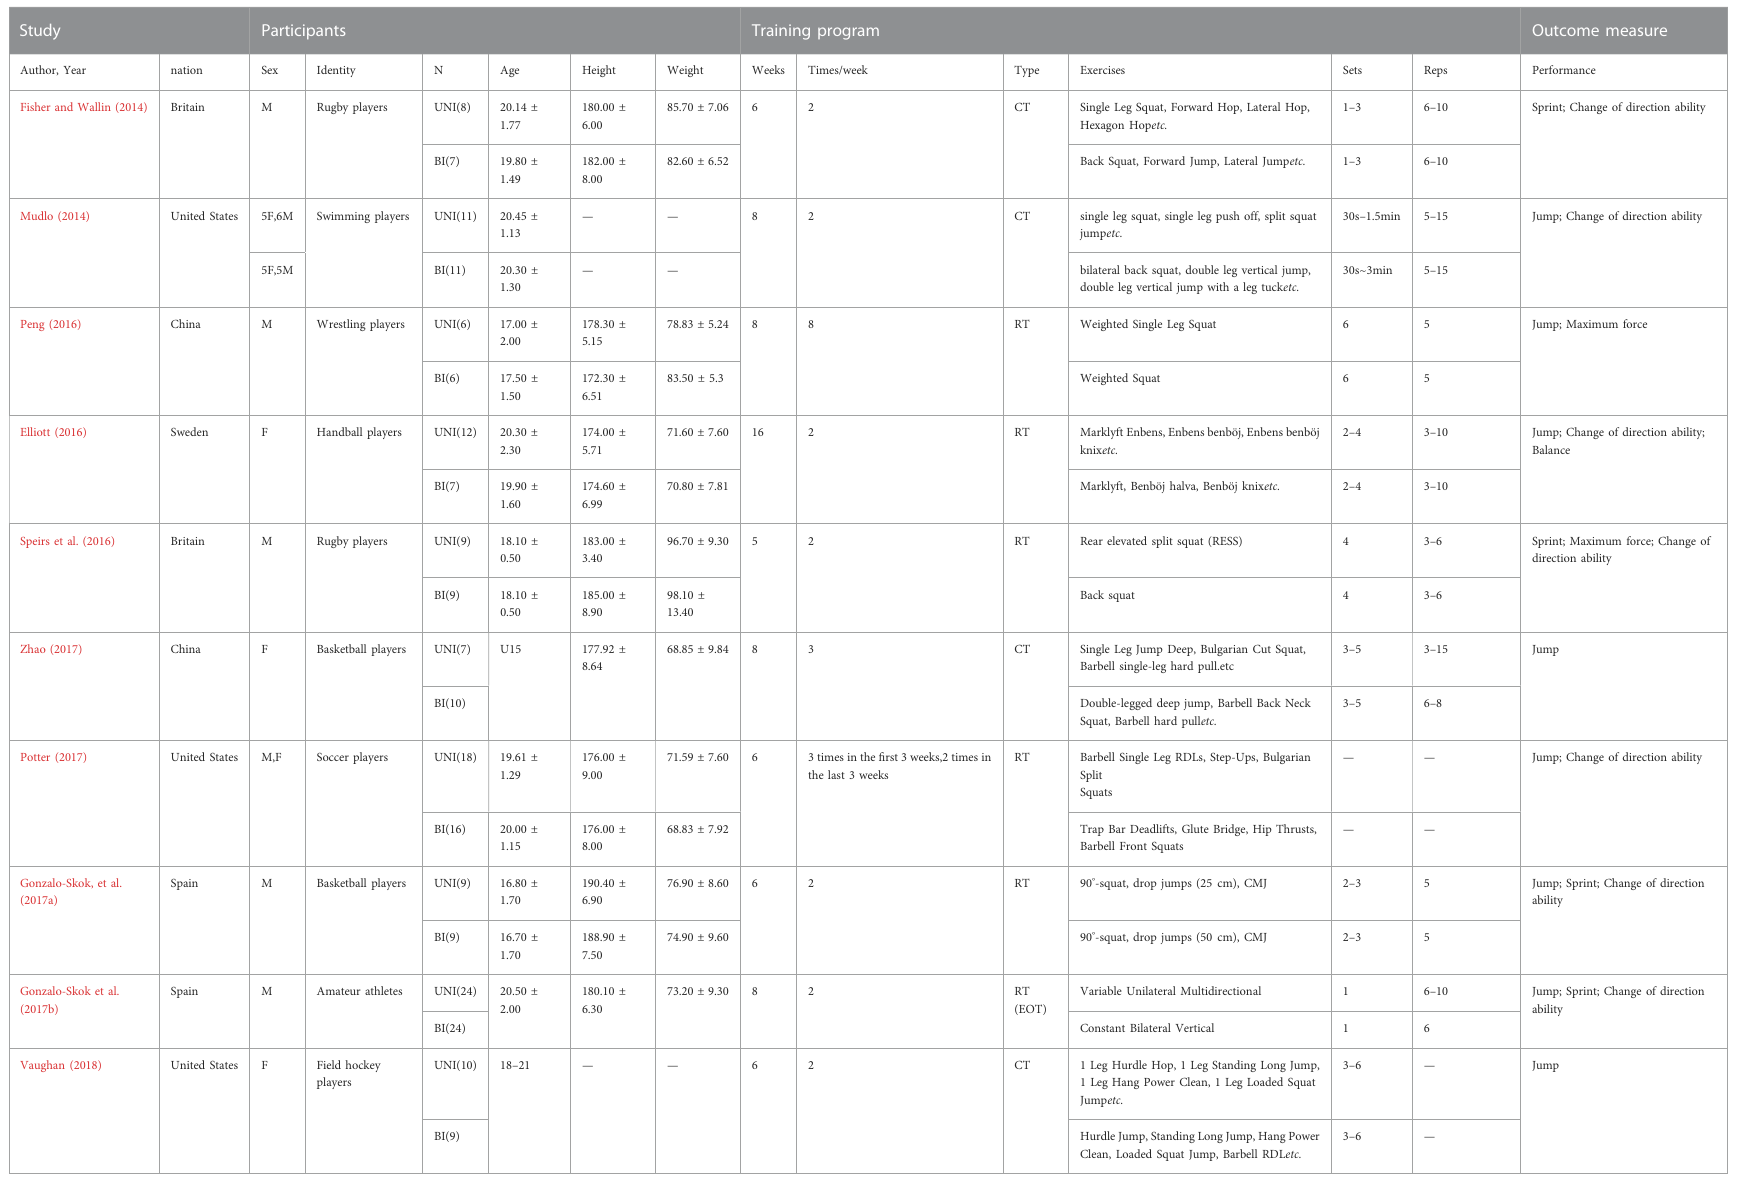
TABLE 2 List of basic characteristics of the included literature Abbreviations: M = male; F = female; RT = Resistance training; PT = Plyometric training; CT = complex training; EOT = Eccentric-overload training.